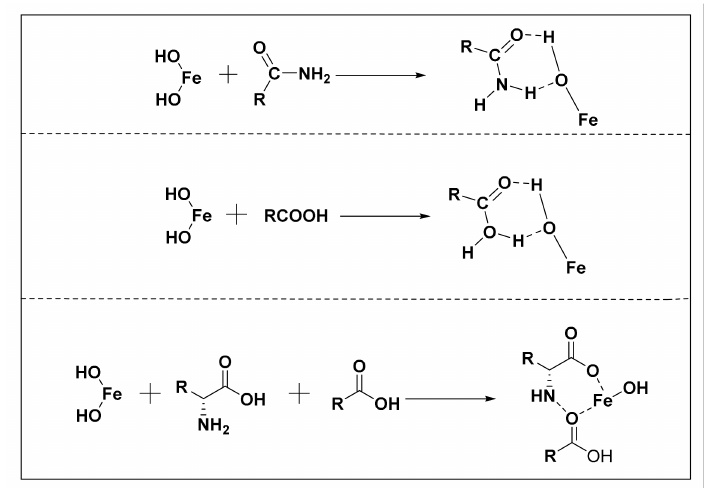
Figure 7. The association equations of combined collector (NaOL and WEO) on the ilmenite